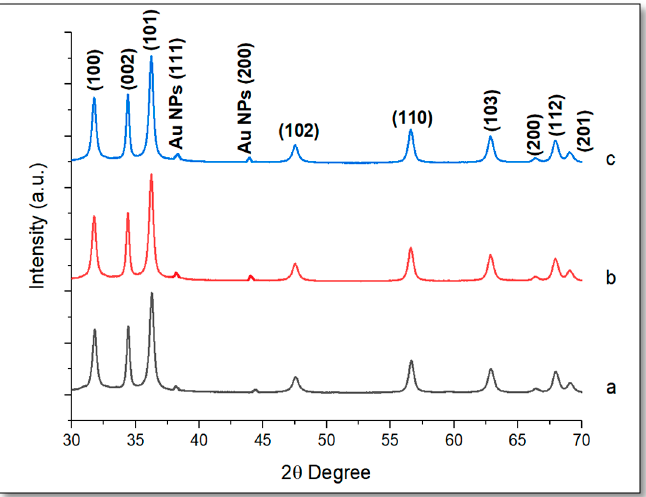
ff ractometer (XRD) di ff raction patterns for 10% Au@commercial ZnO–graphene ( a ); Figure 2. X-ray diffractometer (XRD) diffraction patterns for 10% Au@commercial ZnO–graphene ( a ); Figure 2. X-ray di 10%Au@ZnO NPs–graphene ( b ); and 10%Au@ZnO NWs–graphene ( c